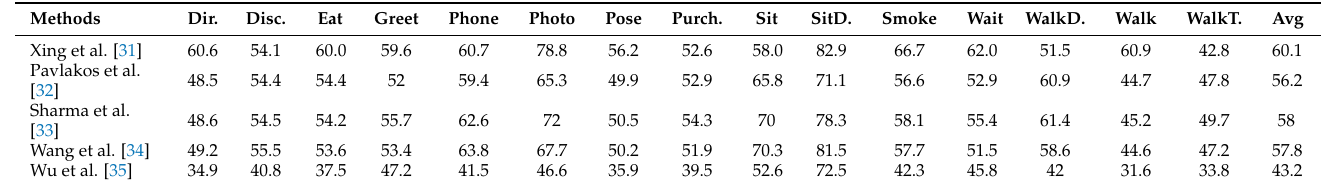
Table 4. Summary of performance on Human3.6 Protocol #1 (MPJPE: